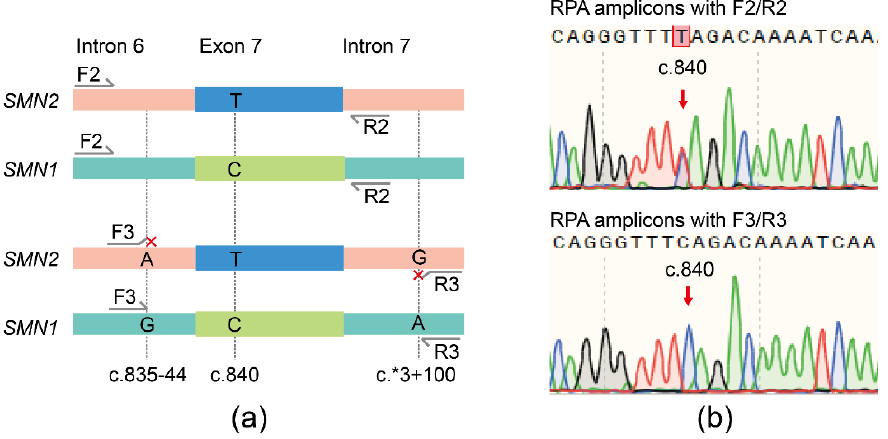
Figure 2. Diagram of RPA primers and sequencing results of RPA products. ( a ) Innate SNVs be- tween SMN1 and SMN2 located at the 3′ end of primers F3/R3. ( b ) Sanger sequencing of RPA SMN1 and SMN2 located at the 3 (cid:48) end of primers F3/R3. ( b ) Sanger sequencing of RPA products products amplified with the primers F2/R2 and F3/R3. amplified with the primers F2/R2 and